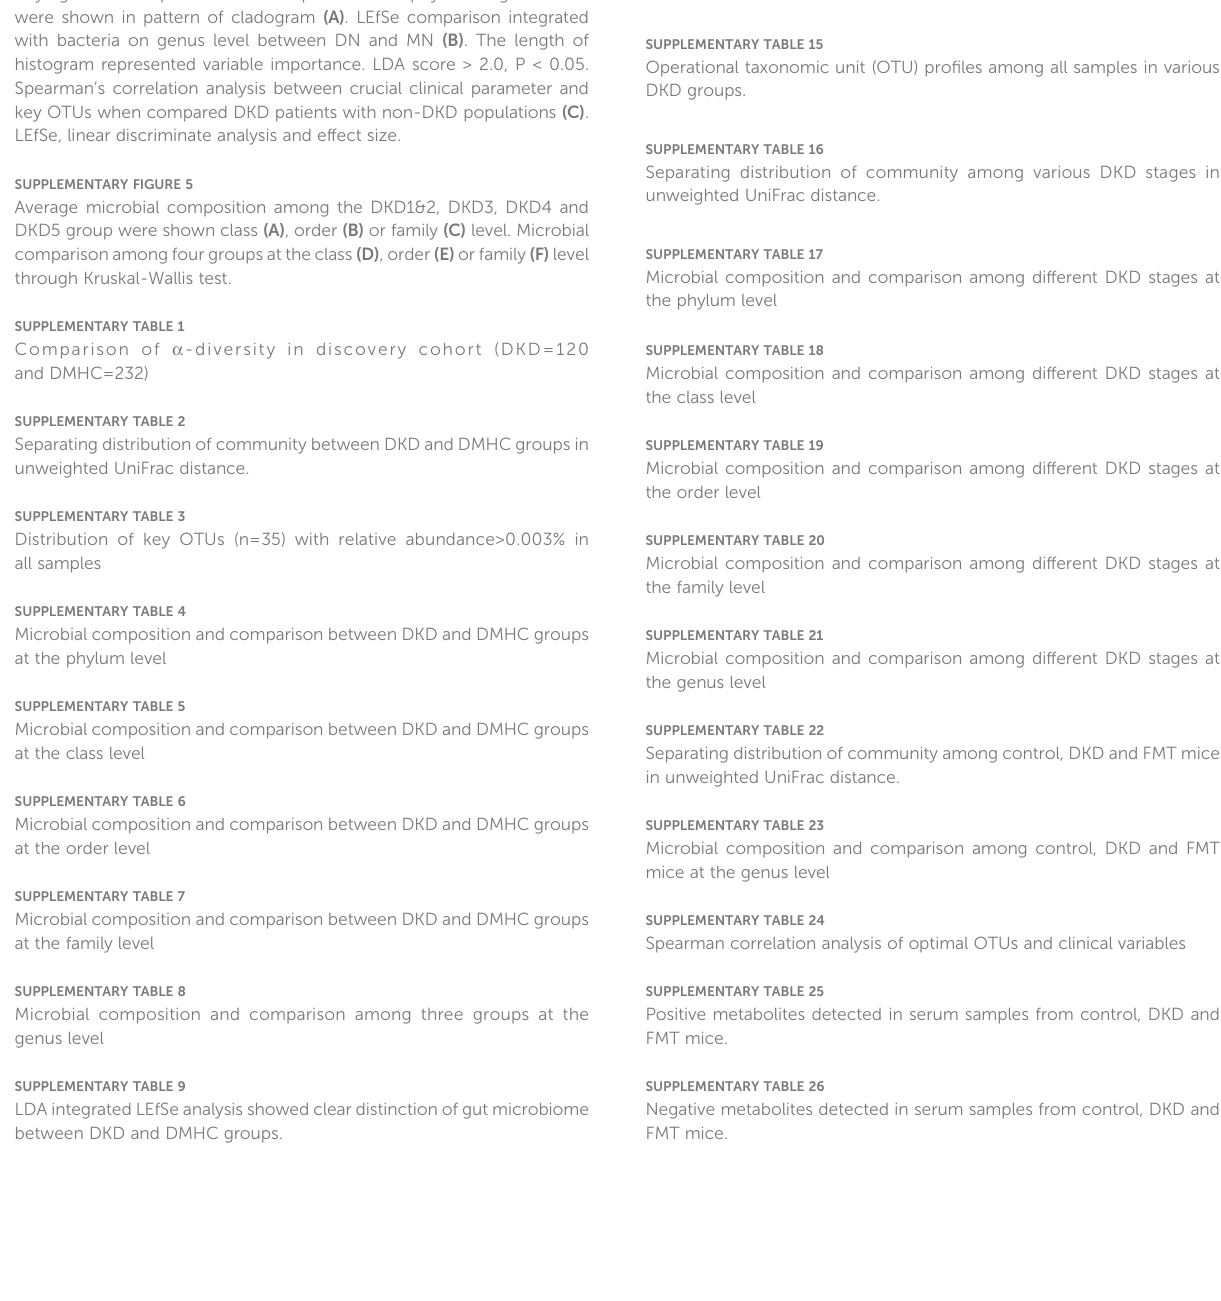
SUPPLEMENTARY TABLE 14 Comparison of a -diversity among various DKD stages (DKD1&2 = 12, DKD3 = 26, DKD4 = 112 and DKD5 =